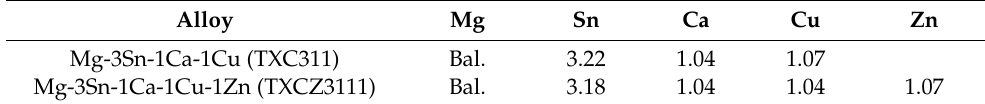
Table 1. Actual chemical composition of the magnesium alloy (wt%).